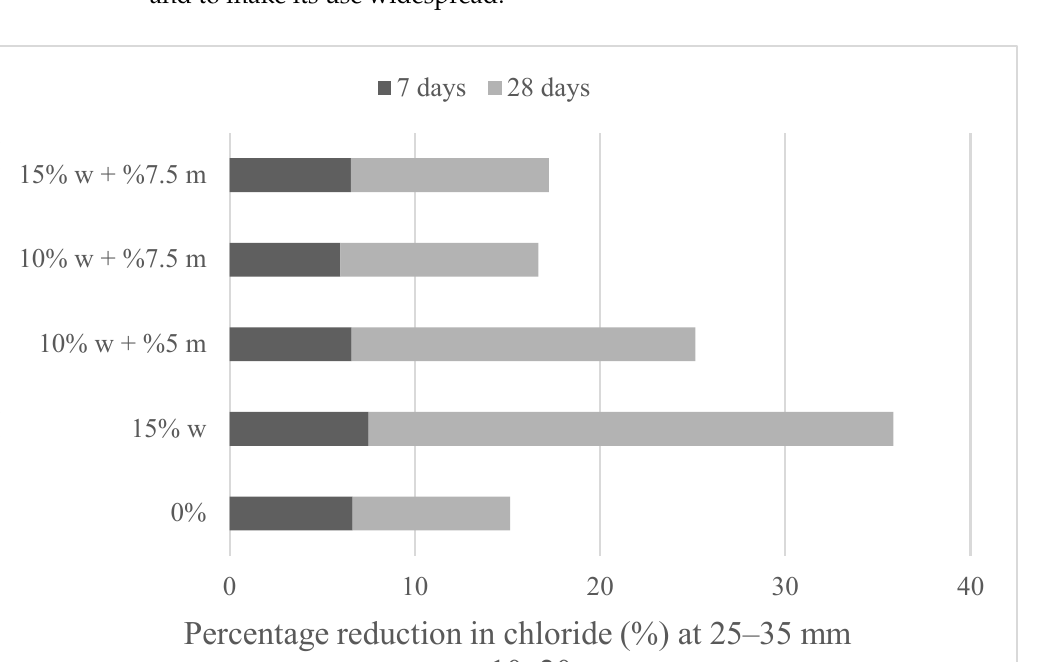
Table 3. Usage and different effects of wollastonite in the literature.